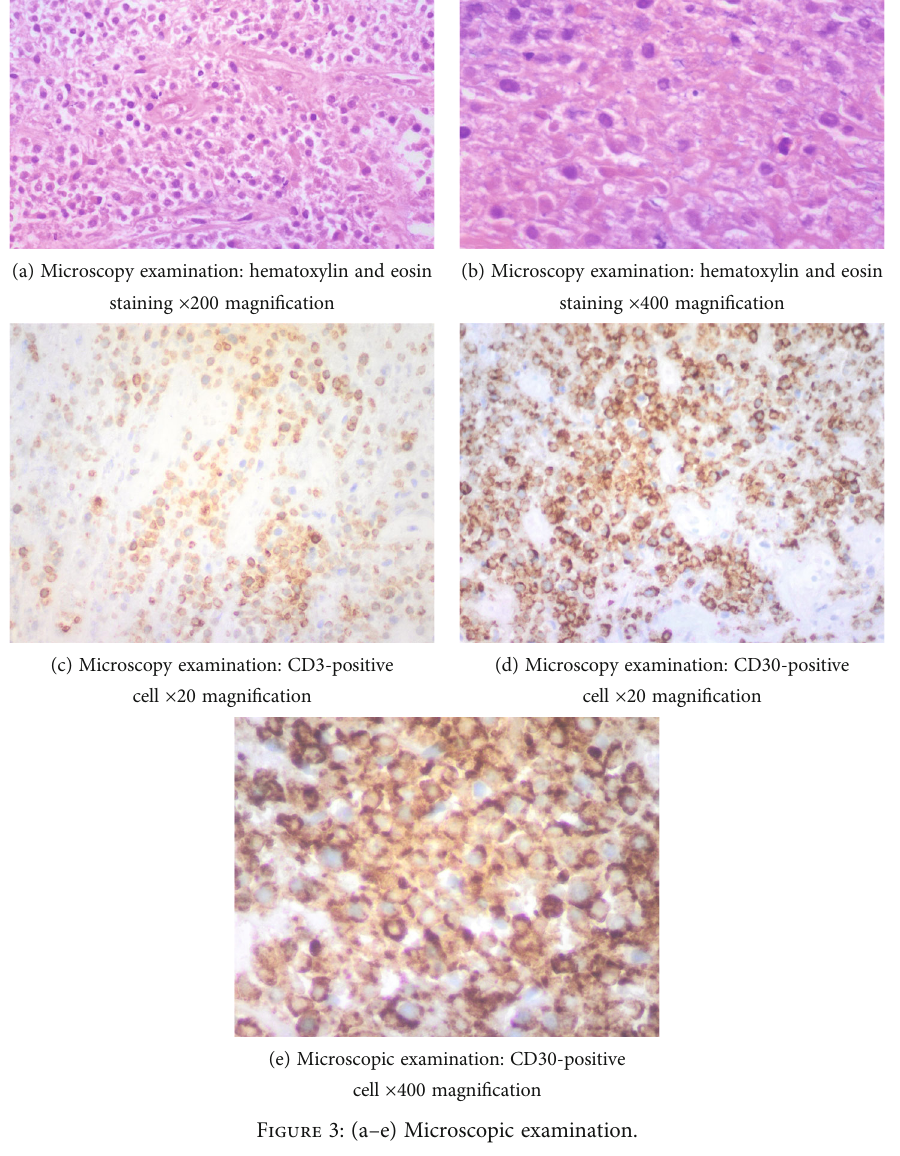
Figure 3: (a – e) Microscopic